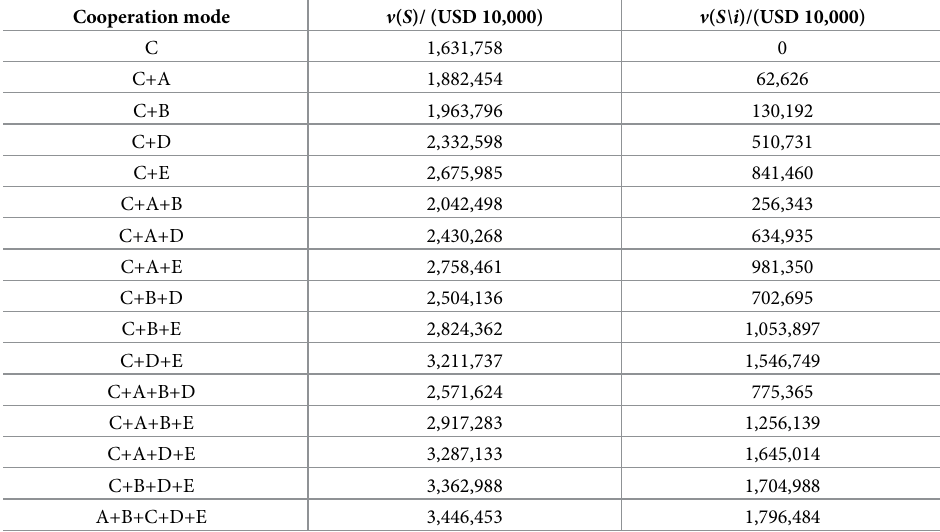
Table 9. Profits of 16 cooperation modes between Thailand and other four countries.